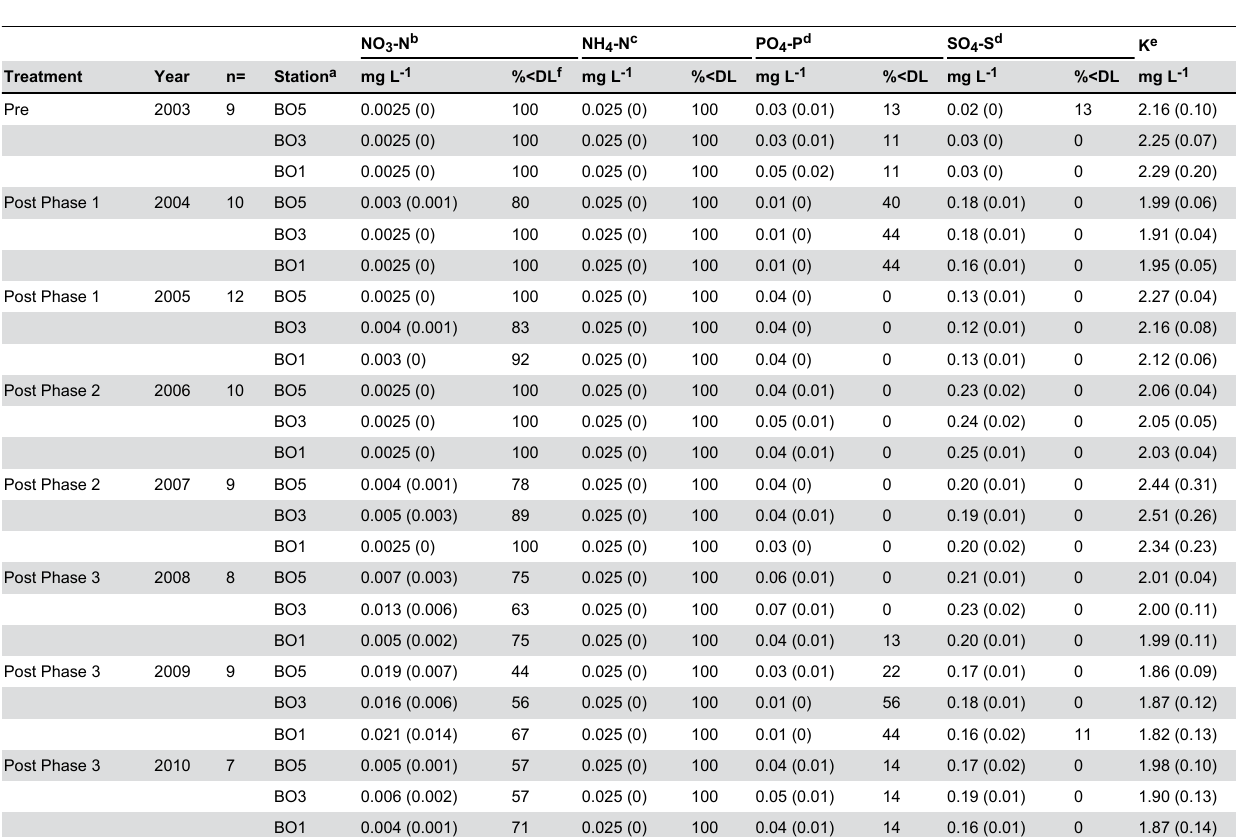
Table 5. Mean annual nutrient concentrations measured at Bogard